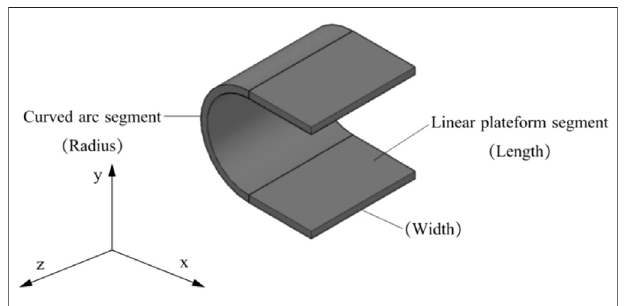
FIGURE 1 | U-shaped steel